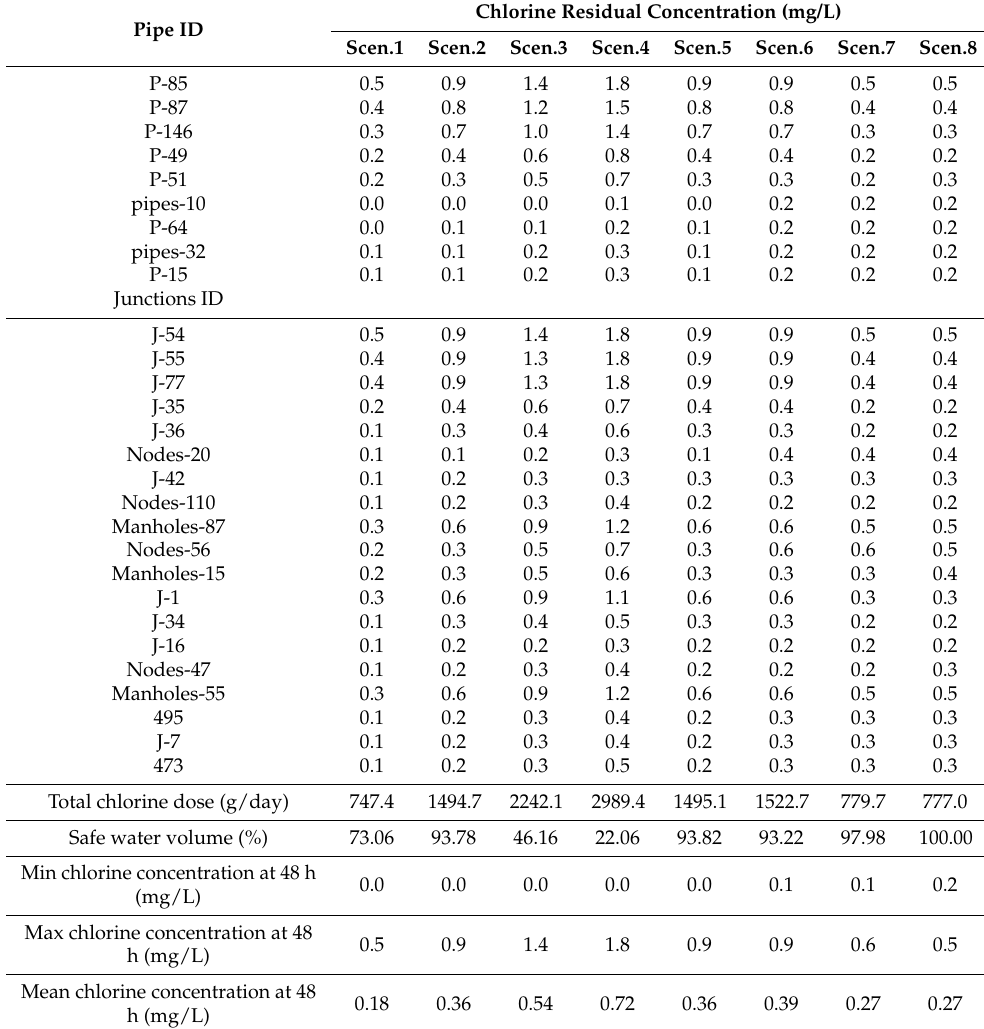
Table 4. Chlorine residual concentrations (mg/L) at selected pipes and nodes for scenario